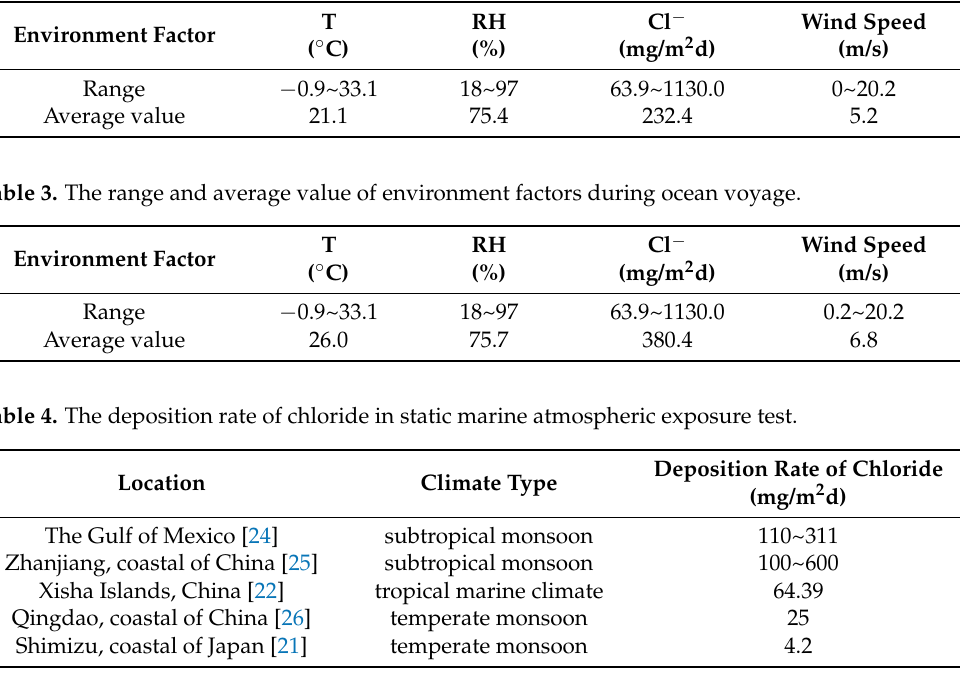
Table 2. The range and average value of environment factor during exposure period.